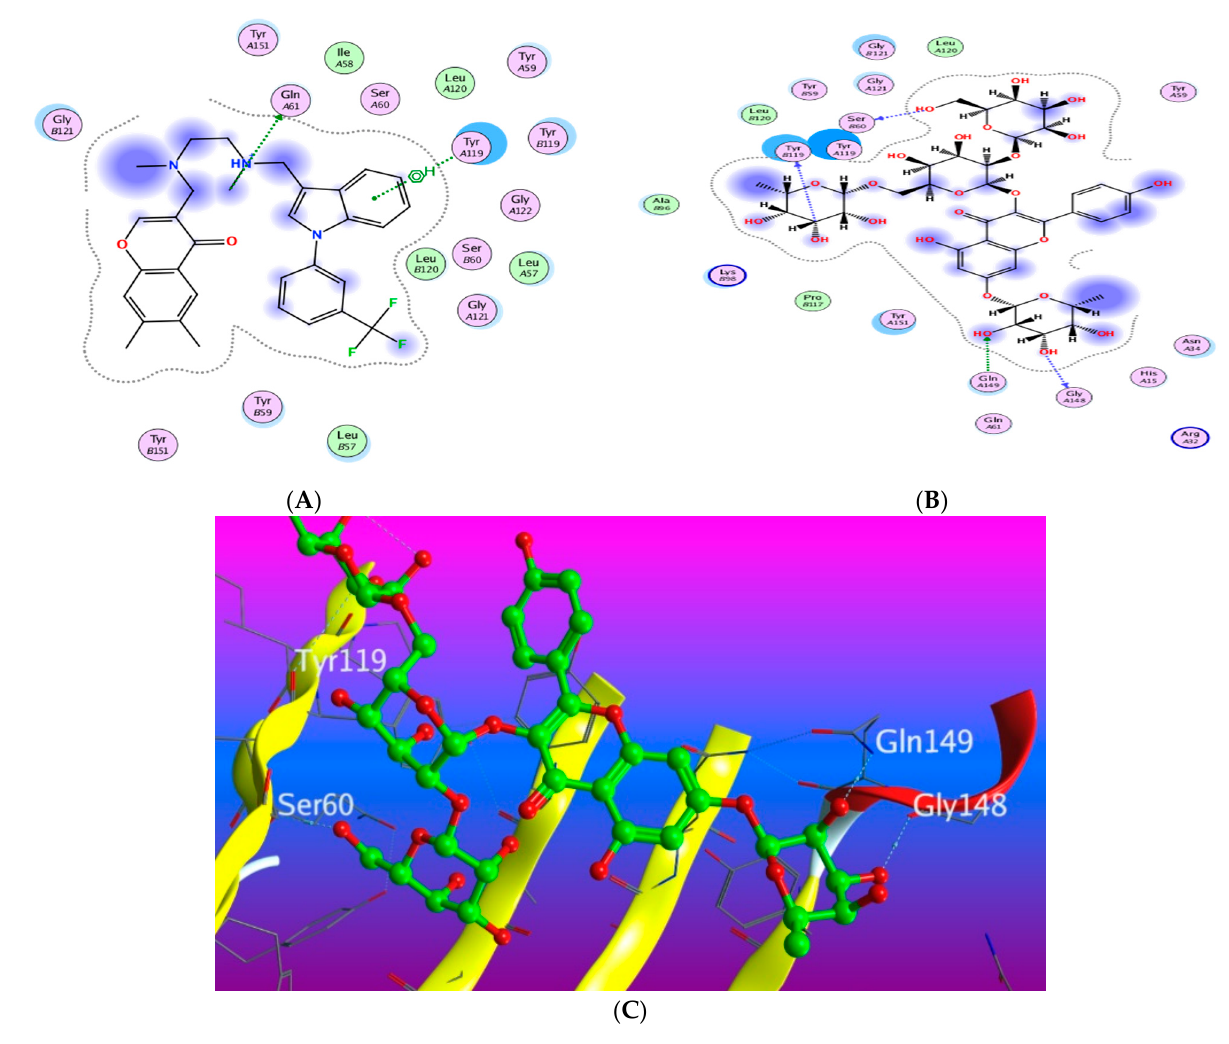
Figure 8. Docking results of compound 14 in the active pocket site of TNF- α (PDB:2AZ5): ( A ) 2D interactions of ligand; ( B ) 2D interactions of compound 14 ; ( C ) Docking pose of compound 14 .